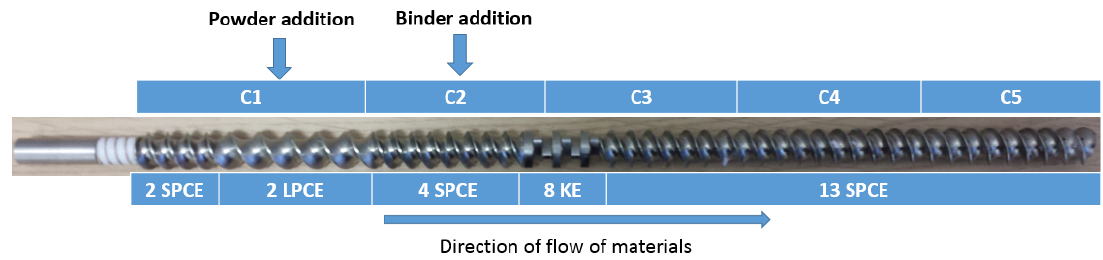
Figure 1. Screw configuration used in the experiments (SPCE, short pitch conveying element; LPCE, long pitch conveying element; KE, kneading element; C1 to C5, compartments/ports along the length of the barrel).